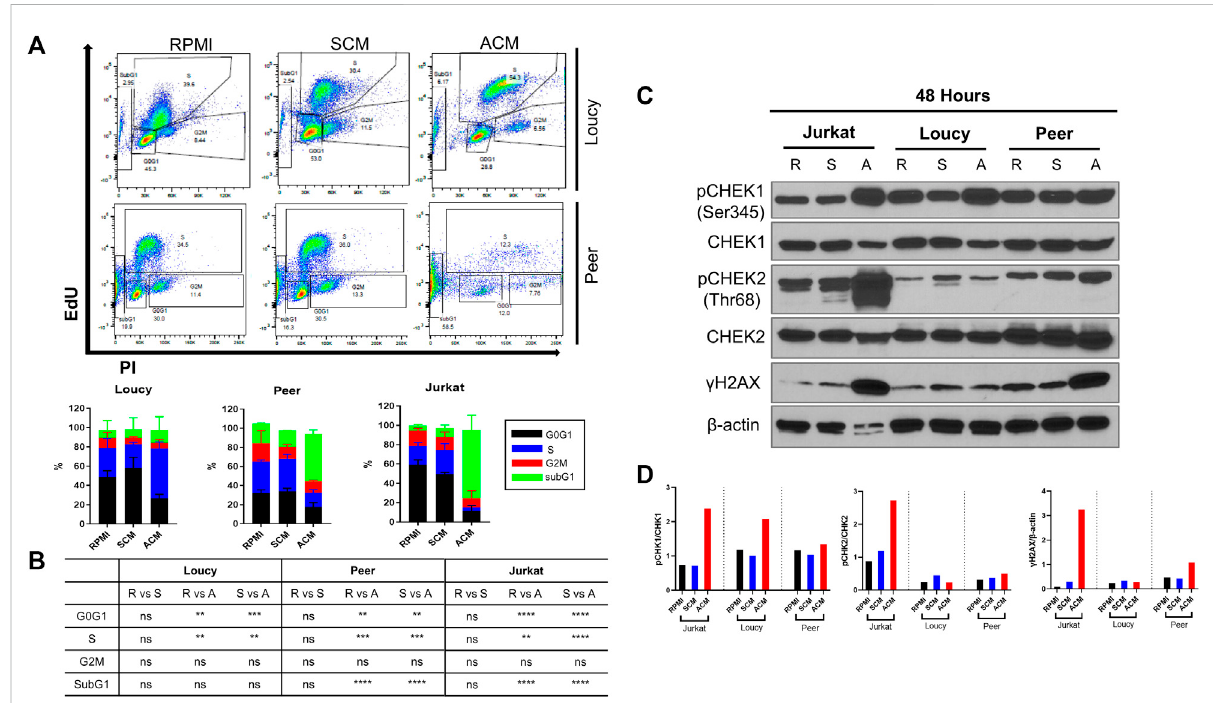
FIGURE 3 Adipocyte secretome induces cell progression in human T-ALL cells with concomitant DNA damage. (A) Human T-ALL cells (Loucy and Peer) wereculturedinunconditionedmediaRPMI,SCM,orACMfor72 h,andcellcycleprogressionwasdeterminedusingEdUanalysis via fl owcytometry. Representative fl owcytometrydataareshown. (B) Quantitativeresultsareshownforthreeindependentexperiments. (C) HumanT-ALLcells(Jurkat, Loucy,andPeer)wereculturedfor48 hasdescribedin (A), andWesternblotanalysiswasperformedtodetecttheproteinlevelsoftheindicated cellcyclecheckpointregulators(CHEK1/CHEK2)andindicatorsofgenotoxicstress( γ H2AX).Primarydatafromarepresentativeexperimentisshown. (D) Protein expression levels from the Western blot experiments were determined using ImageJ analysis and a representative blot from two independent experiments is shown. R = RPMI, S = SCM, and A = ACM in (B,C)